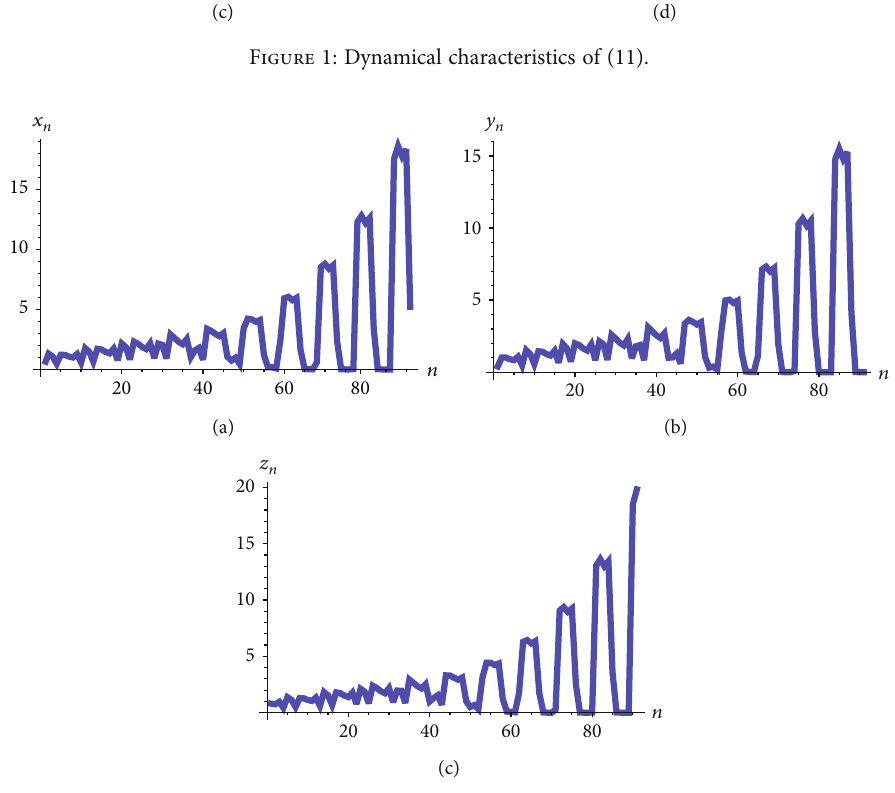
Figure 1: Dynamical characteristics of